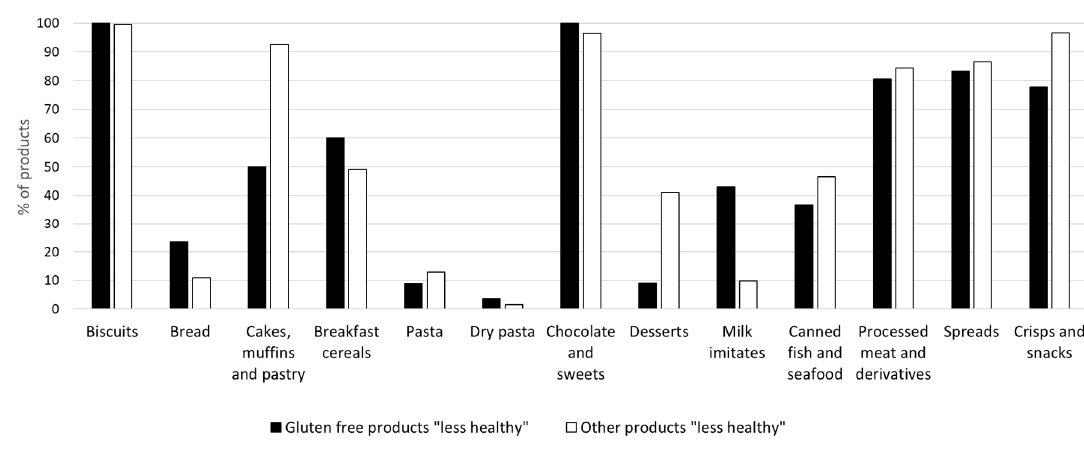
Figure 1. Proportion of products scored as “less healthy” (by the nutrient profiling scoring criterion (NPSC) in specific food categories for products labelled as gluten-free ( ■ black bars) and for products without such labelling ( □ white bars).